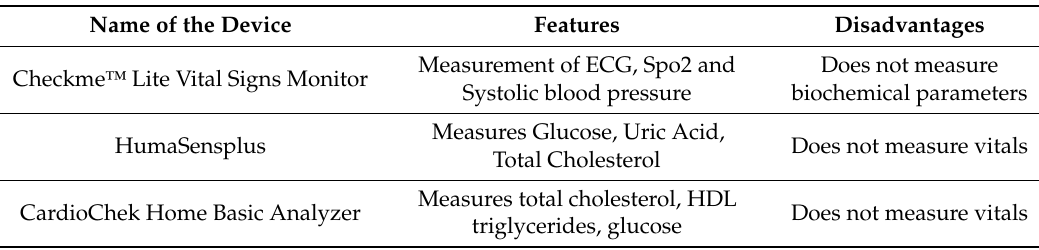
Table 1. Comparison of integrated point-of-care